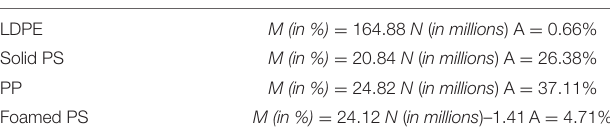
TABLE 7 | Relations between the mass of MPs (0.5–5mm); M % , expressed in per cent of the initial mass of LPIs; and the number of MPs particles; N , expressed in millions; generated from 1kg of LPIs; for the types of plastics used in the